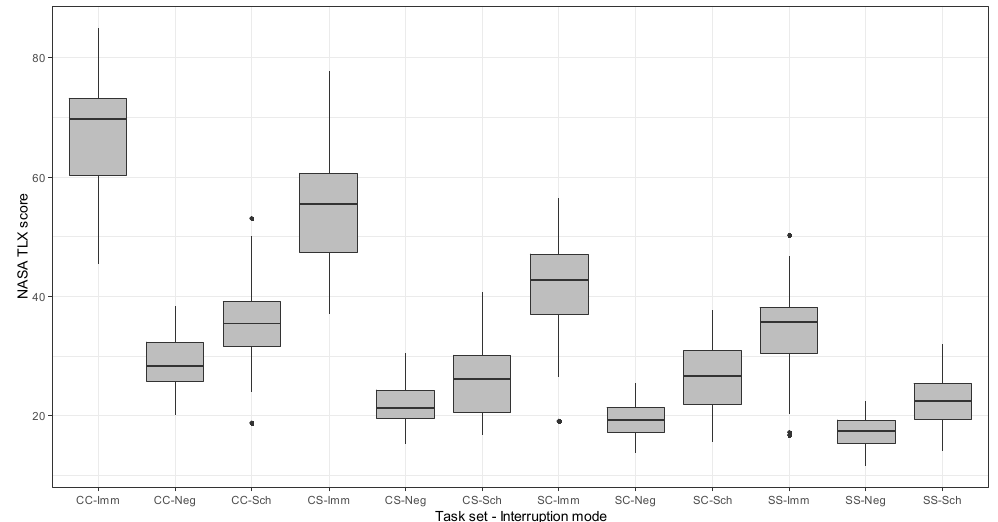
Figure 5. NASA TLX data by task set and interruption coordination mode.